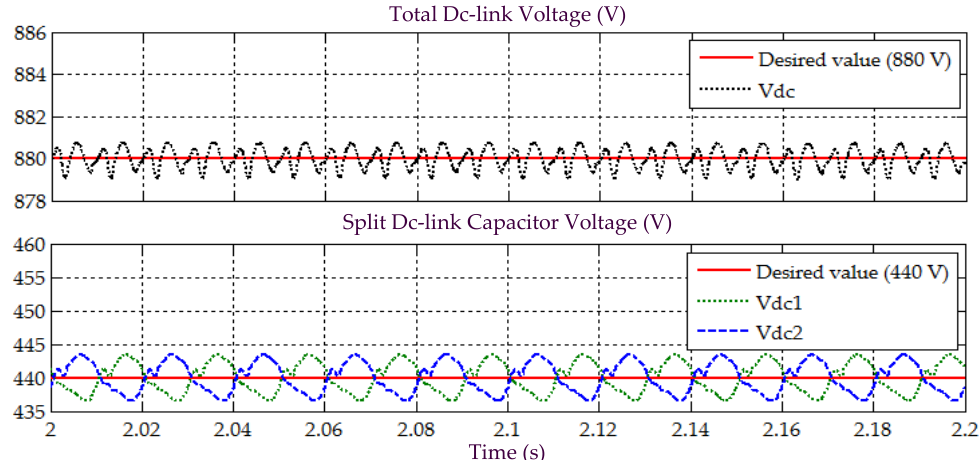
Figure 19. Simulation result obtained under Scenario C for Load 2, showing the total dc-link voltage V dc , and voltages across split dc-link capacitors V dc 1 and V dc 2 , demonstrated by SAPF while applying the proposed STF- dq 0 technique.